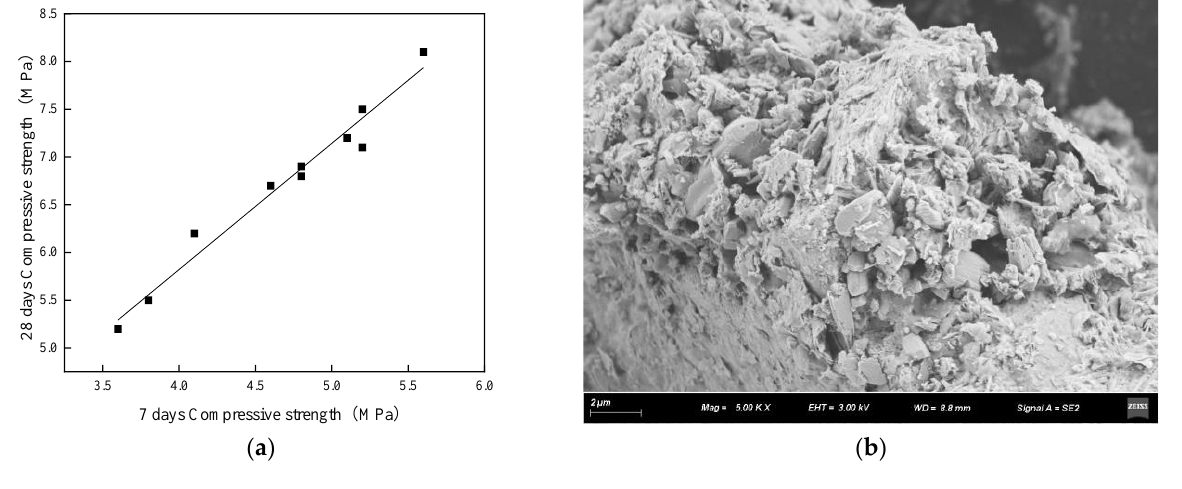
This is due to the existence of a great number of pores within the planting concrete, which allows the cement and water to come into full contact at an early stage, and thus the hydration is adequate. As shown in Figure 11b, at the age of 7 days of planting concrete, the surface of the slurry is relatively rough, but its hydration products can be closely wrapped around the aggregate, and the internal material structure is basically continuous, without the formation of cracks and other defects.